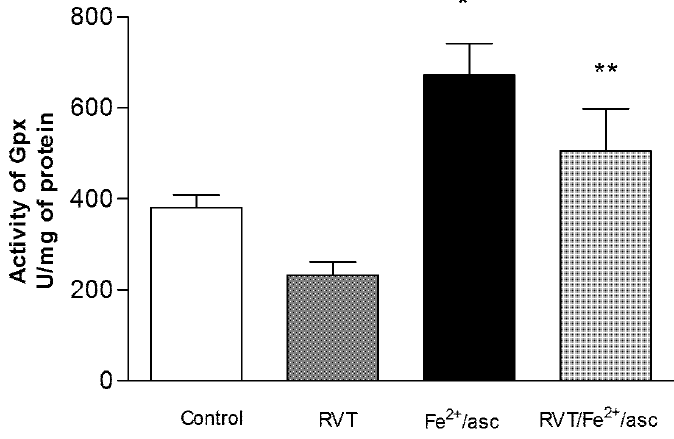
Figure 3. Effect of RVT on GPX activity. Spermatozoa were obtained from ductus deferens in M-16 medium, pooled and incubated with RVT, Fe 2+ /asc or RVT + Fe 2+ /asc. Activity of GPX was measured with a spectrophotometer after using the RANSEL assay kit. Values represent the mean ± SD of three independent experiments performed in duplicate. * p < 0.05 vs. control group. ** p < 0.05 vs. Fe 2+ /asc group.